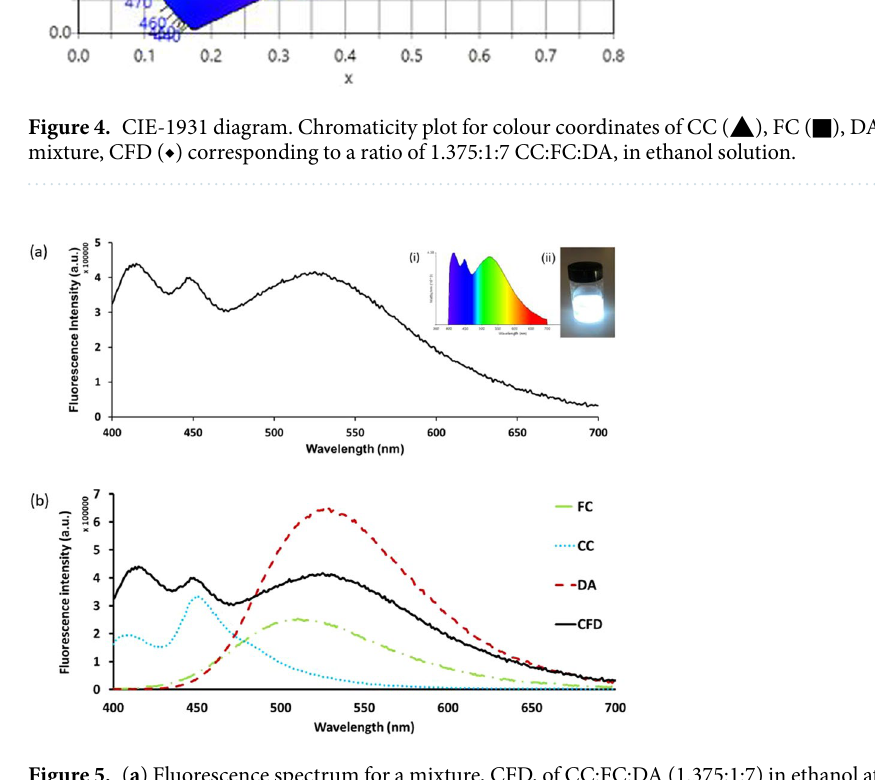
the gel was filtered and allowed to dry. The dried aerogel then exhibits WLE when excited under UV light illumi- nation. The fluorescence emission spectrum of the mixture incorporated in to aerogel is shown in Fig. 6a, which covered the visible region from 400 to 650 nm. The aerogel shows good WLE under UV light (inset, Fig. 6a(ii)). A good CIE coordinate value of (0.27, 0.33) was obtained for the WLE aerogel from the corresponding emission spectrum, excited at 390 nm (Fig. 6b). Finally, as an exemplar application to demonstrate the potential of this approach, we applied the WLE aerogel in an ad-hoc fashion as a coating for a commercial UV LED. Side by side images of the regular UV LED and the modified aerogel WLE LED are shown in Fig. 7. As can be observed, the modified LED produces a uniform WLE.